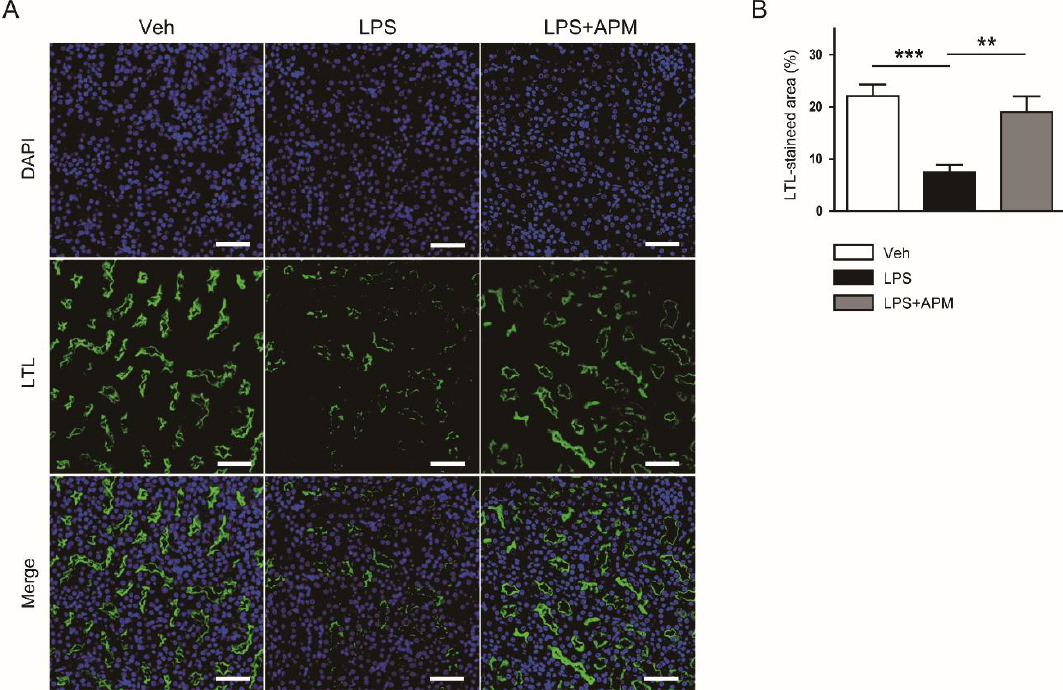
Figure 3. E ff ect of apamin on LPS-induced loss of brush borders in the proximal tubule. ( A ) Immunofluorescent staining with fluorescein isothiocyanate-conjugated lotus tetragonolobus lectin (LTL) of kidney tissues. Scale bars: 50 µ m. ( B ) Percentage of stained areas for LTL. n = 8 per each group. ** p < 0.01 and *** p <